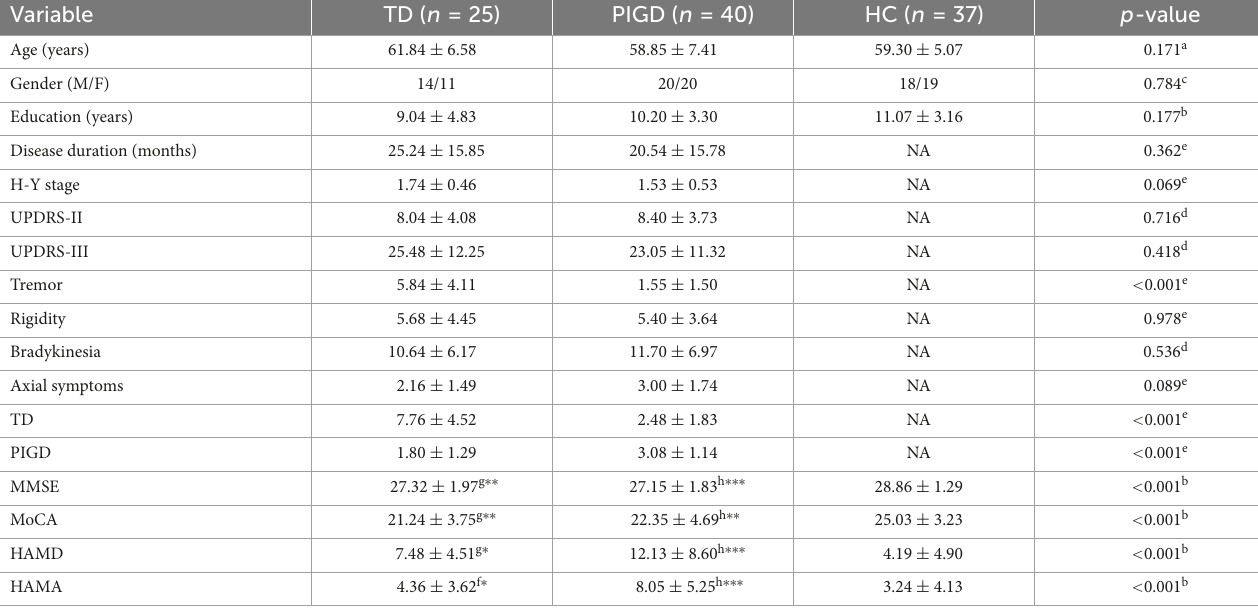
TABLE 1 Demographic and clinical characteristics of the participants (mean ±